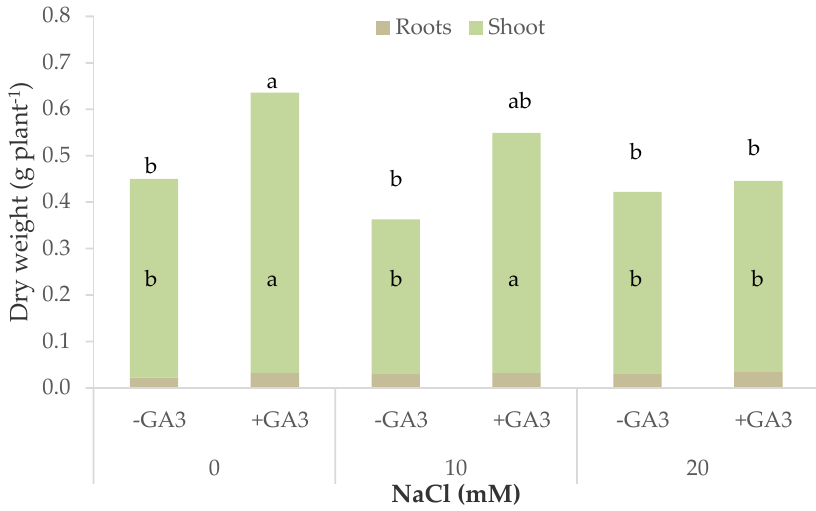
Figure 3. Total, shoot, and root dry biomass of rocket plants grown in nutrient solutions containing different levels of NaCl and gibberellic acid (10 − 6 M GA 3 ) (bars of the same color with different letters are significantly different at p < 0.05 according to the LSD test).